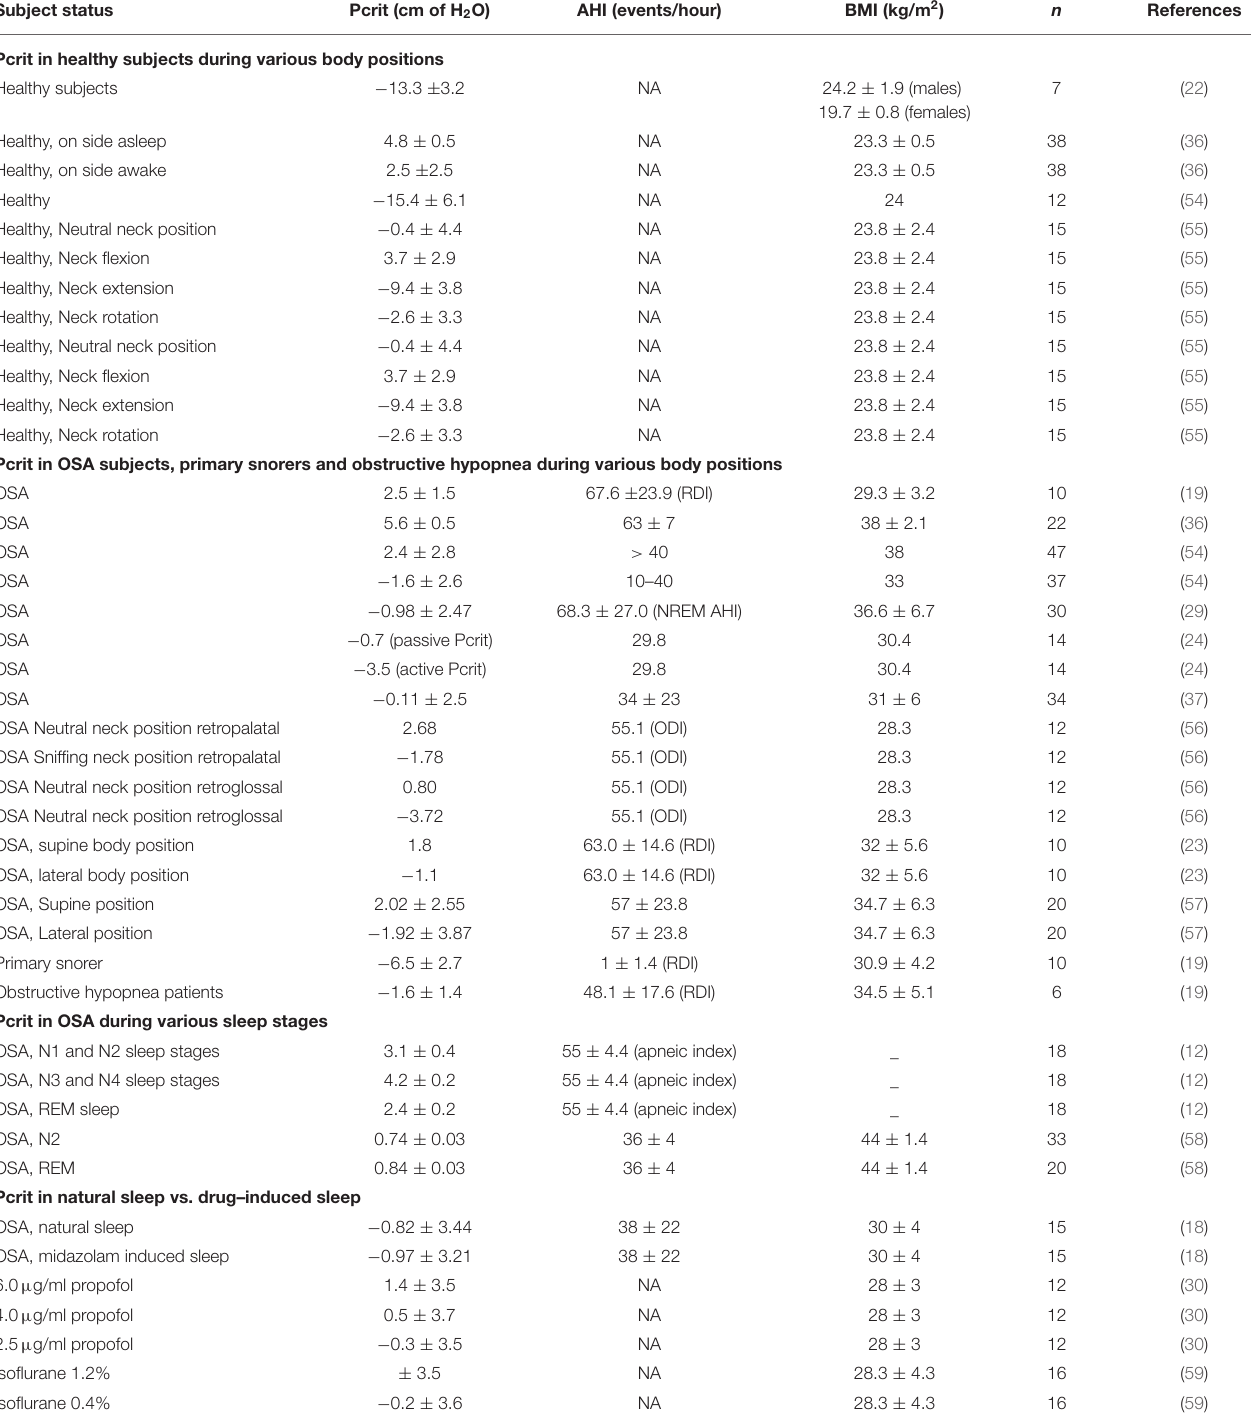
TABLE 1 | Overview of the measured critical closing pressure (Pcrit) from various studies under various situations with varying subject